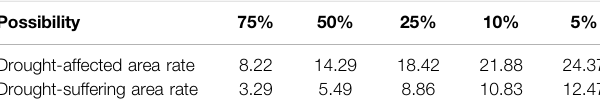
TABLE 3 | Frequency characteristic value of drought-affected area and drought- suffering area in China